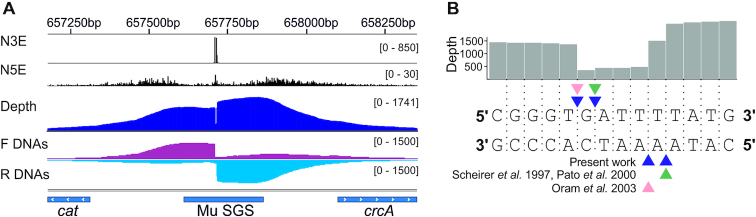
Signal structure at the strong gyrase binding site from bacteriophage Mu (Mu SGS). (A) Profiles of the number of 5′- and 3′-ends (N5E and N3E correspondingly) are shown in black. Total coverage depth (Depth) is in blue and coverages for DNA fragments that were aligned in forward and reverse orientations (F DNAs and R DNAs correspondingly) are in red and sky blue respectively. Tracks height (depth) are shown in brackets. The data visualized in IGV (58). (B) Close-up of the cleavage site. Coverage depth around the site is shown as a grey track, local sequence lies below. Cleavage sites known from the existing literature are shown (31,45,46).